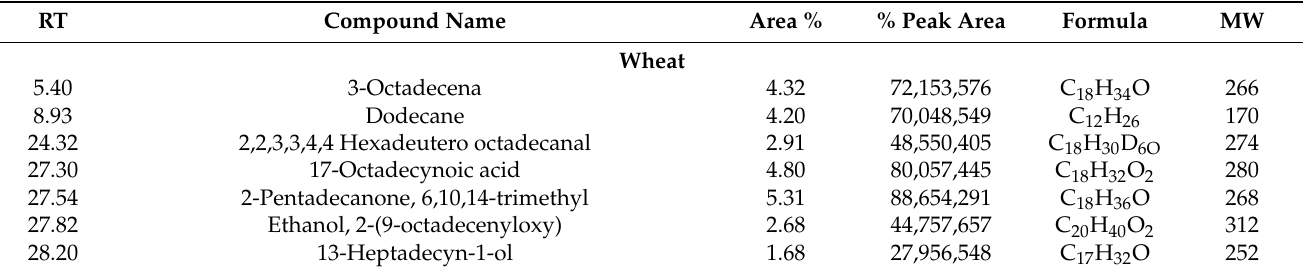
Table 4. The GC-MS analysis of the ethanolic extract of wheat and barley